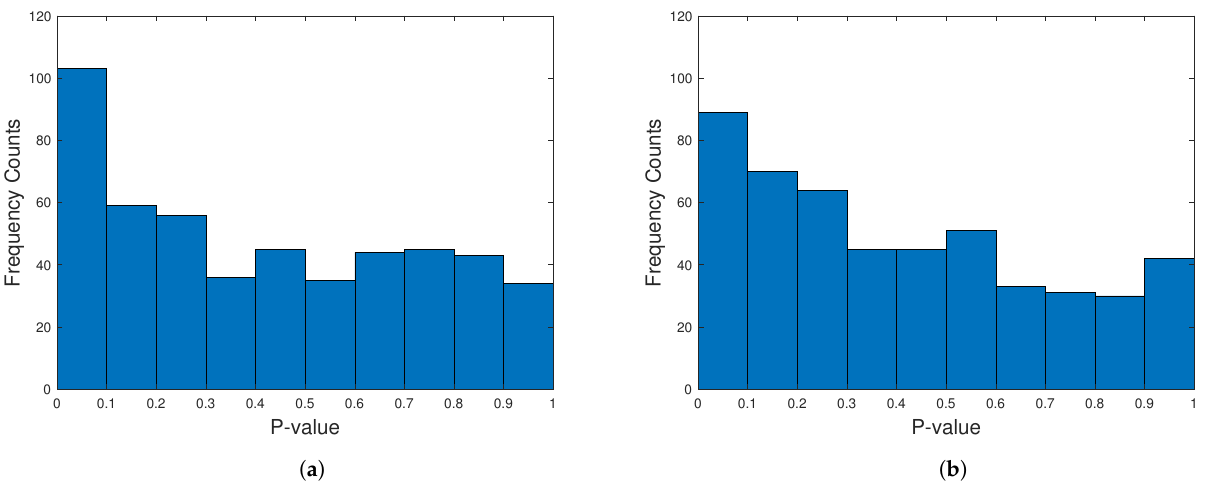
Figure 9. Histogram representing the distribution of p -values for 500 test runs with the ( a ) SHA-512 data variant and ( b ) the Toeplitz-hashed